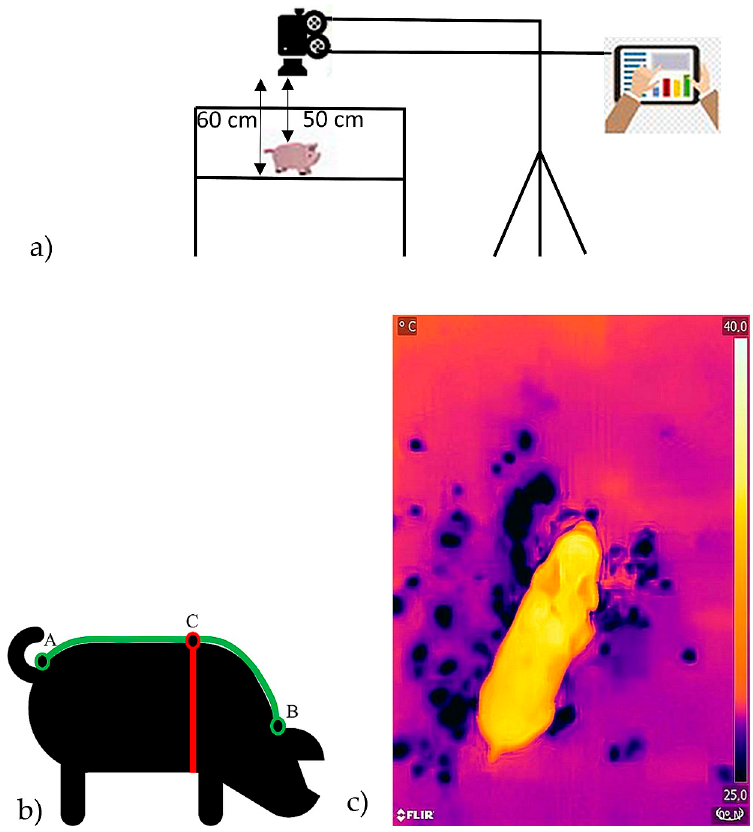
Figure 1. ( a ) Setup of thermal imaging, animal’s individual top-view thermal images were recorded in a standardized distance, and ( b ) manual measurement of body length (A to B) and chest girth (C). ( c ) Example of a thermal image, where dark-blue/purple indicates low temperature and yellow/white indicates high temperature.